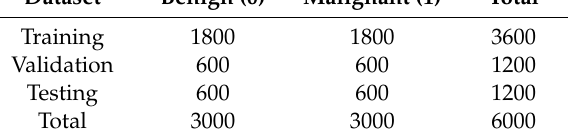
Figure 4. Image preprocessing using smoothing and gamma correction. ( a , c ) Original images of benign and malignant tissues, respectively. Here, the images are blurry and exhibit low contrast. ( b , d ) Images after removal of random noise, smoothing, and gamma correction. ( e ) Transformation curve for images with low and high contrast. Because the images in ( a , c ) have low contrast, γ = 2 was applied to adjust their intensities, obtaining images in ( b , d ) that appear clear and “fresh.” Therefore, the tissue components were more visible after transformation, which was important for CNN classification. Table 1. Assignment of benign and malignant samples into datasets for training, validation, and testing.